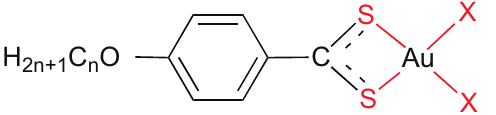
Figure 29. Gold(III) dithiobenzoate mesogens. X = Cl, Br; n = 8, 10; X = Me, n = 8.